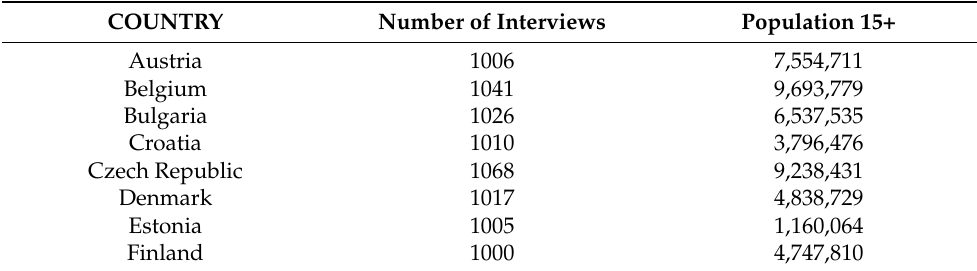
Table 1. Sample size by country, Total population